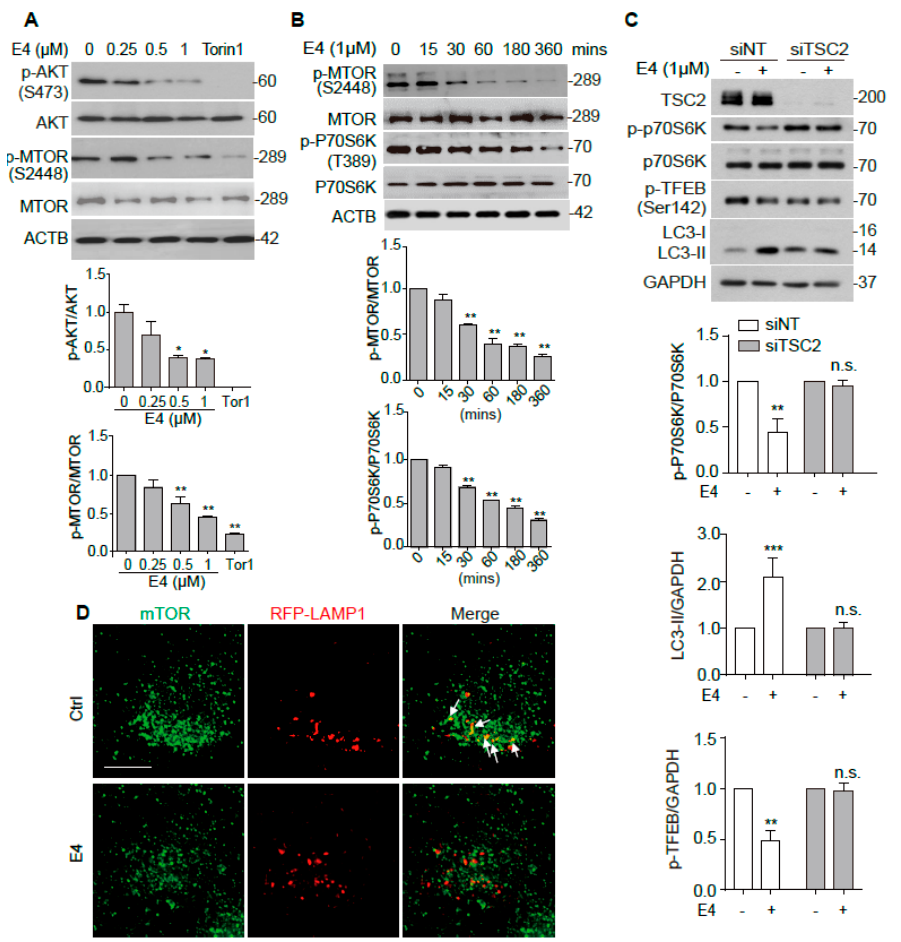
Figure 4. Compound E4 activates TFEB via inhibiting AKT-MTORC1 pathway. ( A ) N2a cells were treated with E4 at indicated concentration and positive control Torin1 (250 nM) for 6 h. Representative blots show the expression of phosphorylated (p-) and total AKT and mTOR. Data are presented as the mean ± SEM from three independent experiments. ( B ) N2a cells treated with 1 µ M